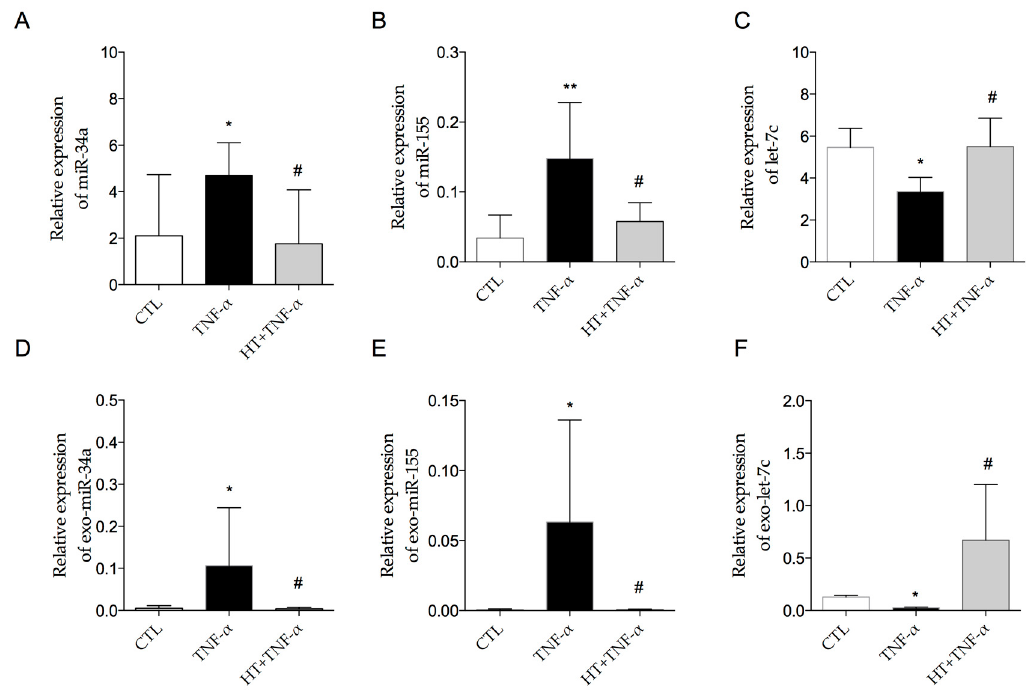
Figure 9. Modulation by HT of TNF- α -induced miRNA expression changes in adipocytes and in exosomes isolated from conditioned media. SGBS cells were treated with 10 µ mol / L HT, and then stimulated with 10 ng / mL TNF- α for 18 hours. Total miRNAs were extracted from cells, and miR-34a ( A ), miR-155 ( B ) and let-7c levels ( C ) were measured by qPCR, analyzed using the Ct method, and normalized to SNORD6 levels. Total miRNAs were extracted from exosomes (exo-miR), and miR-34a ( D ), miR-155 ( E ), and let-7c ( F ) levels were measured by qPCR, analyzed using the Ct method, and normalized to Cel-miR-39. Bars represent means ± SD ( n = 3). * p < 0.05 versus CTL. ** p < 0.01 vs. CTL. # p < 0.05 vs. TNF- α